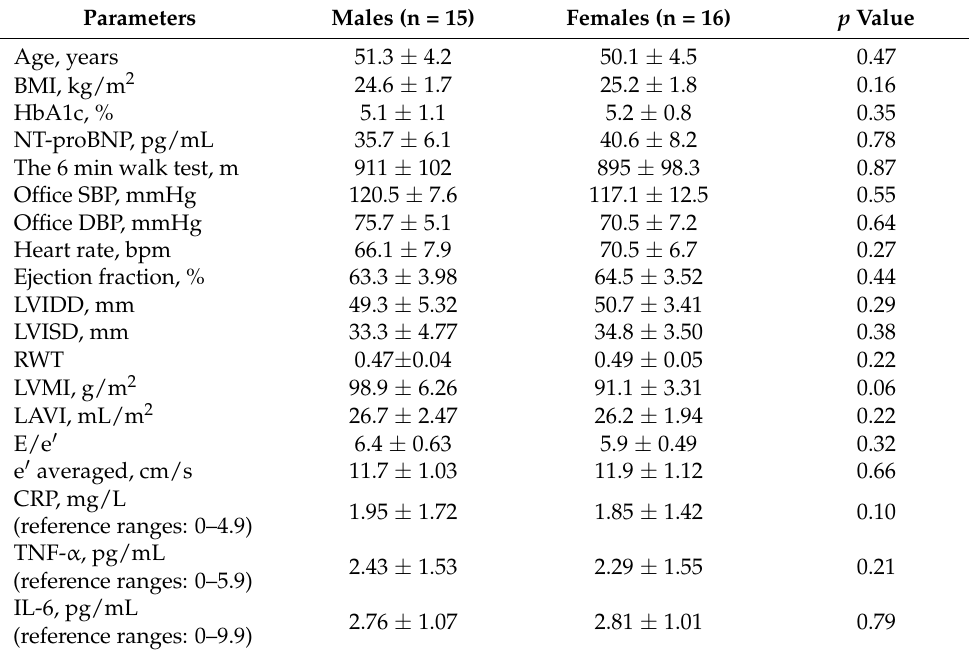
Table 3. The baseline characteristics of the examined healthy individuals (M ± std. d.).